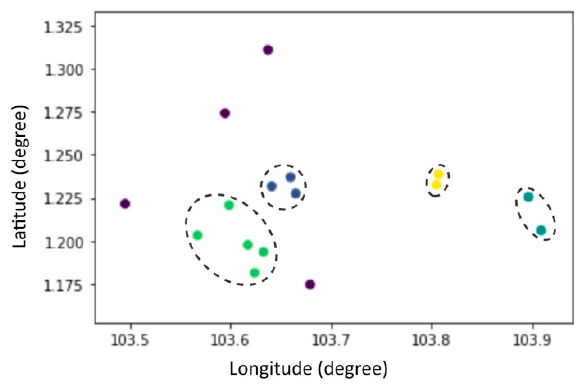
Figure 1. Vessel clusters.